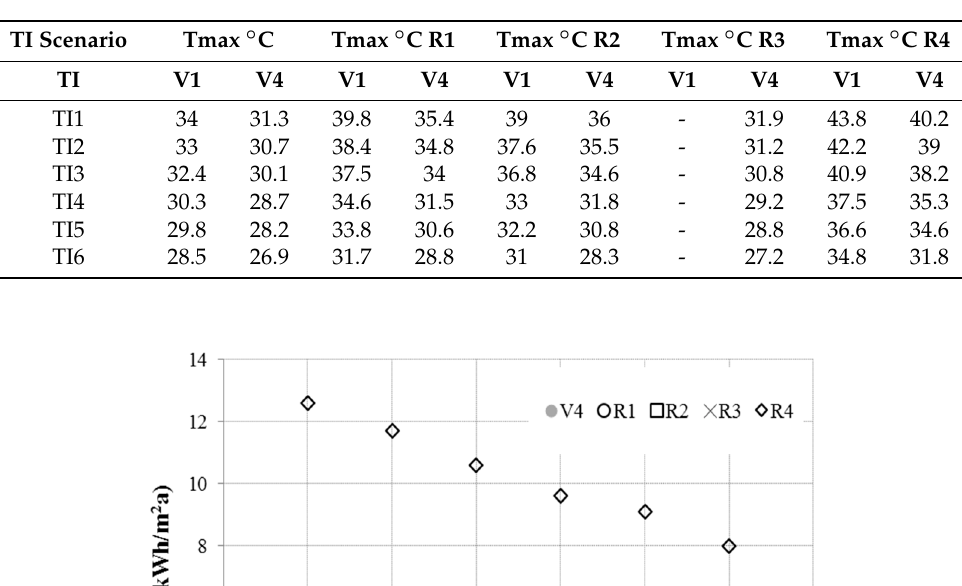
Table 7. Maximum operative temperatures calculated for each TI scenario in relation to V4 and V1. Results are shown for the basic scenario and for each risk factor applied.